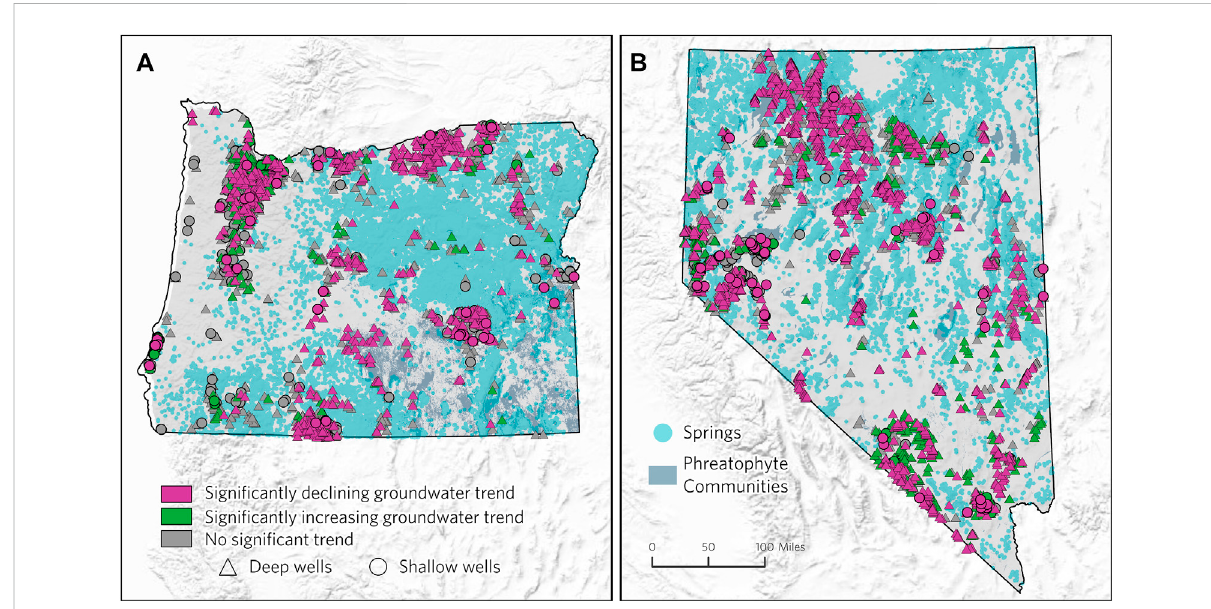
FIGURE 2 Mapofstatistically-signi fi cantgroundwatertrendsamong (A) 3,796state andfederalmonitoringwellsinOregonand (B) 1,879state andfederal monitoring wells in Nevada. Statistical signi fi cance of Sen ’ s slope trends is assessed using a Modi fi ed Mann-Kendall test with p ≤ 0.05. Springs and phreatophyte communities are shown for context.